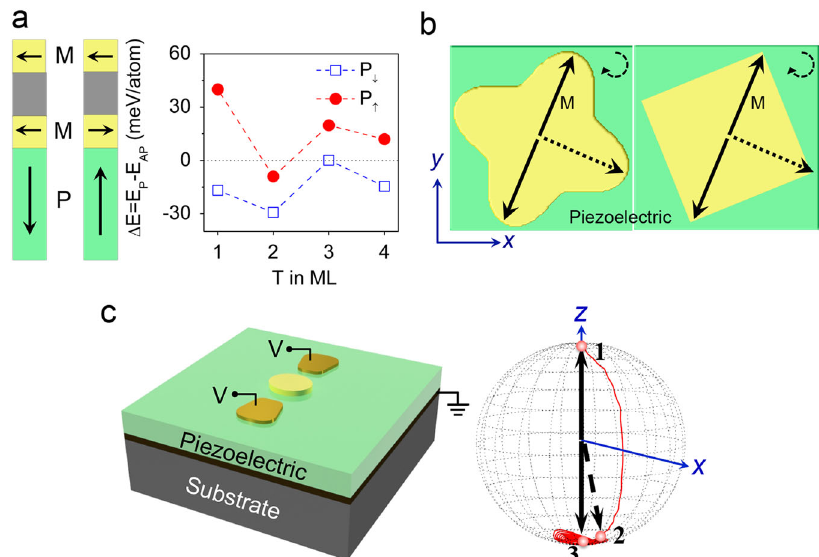
Fig. 7 a Reversing polarization in a ferroelectric layer may change the type of interlayer exchange coupling in adjacent ferromagnetic/non- magnetic/ferromagnetic trilayer mediated by charge densities, demonstrated by fi rst-principles calculation of the energy density difference between the parallel (ferromagnetic) type and the antiparallel (AF) type in a PbTiO 3 /Fe 1 /Au T /Fe 1 heterostructure. Reproduced with permission. 109 Strain-mediated electric- fi eld-driven 180° magnetization switching in b a fl ower-shaped or a square-shaped nanomagnet fabricated on a piezoelectric bottom layer (substrate or fi lm) via two consecutive 90° magnetization switching (see the arrows), adapted with permission, 138, 139 and c an elliptic cylindrical nanomagnet on a piezoelectric fi lm via precessional magnetization switching (see one possible spatial magnetization trajectory on the right ), adapted with permission.